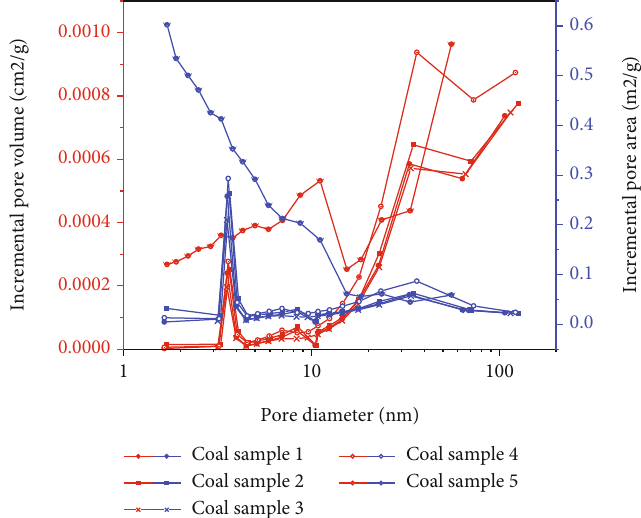
Figure 10: Distribution trend of speci fi c surface area and pore volume of coal